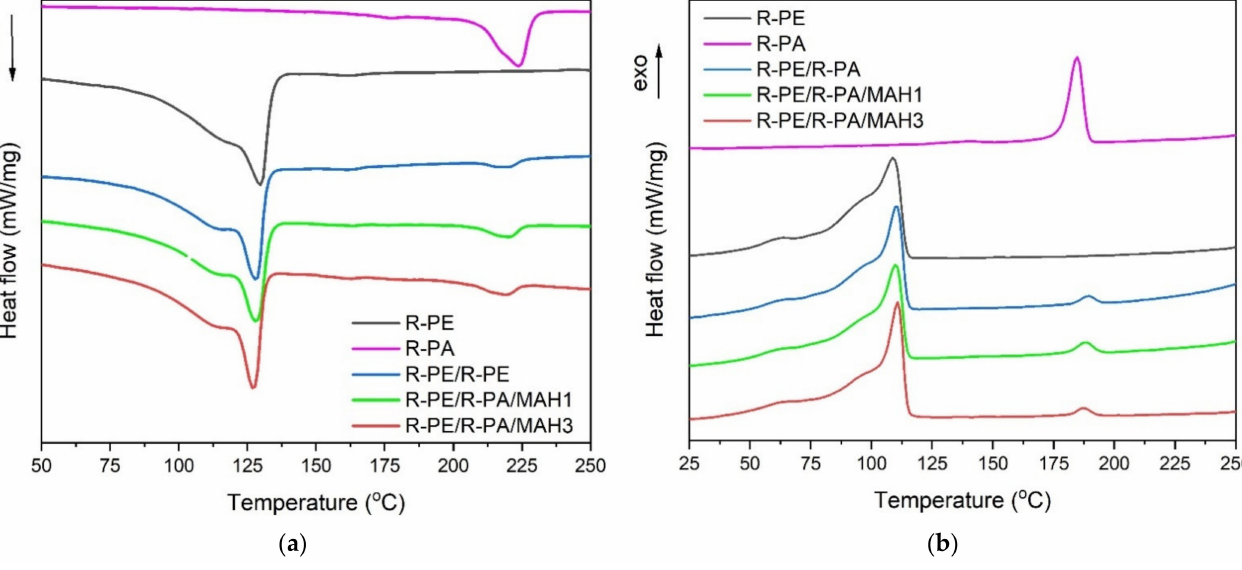
Figure 4. DSC ( a ) melting and ( b ) crystallization curves of R-PE, R-PA, R-PE/R-PA binary blend, and R-PE/R-PA blends grafted by